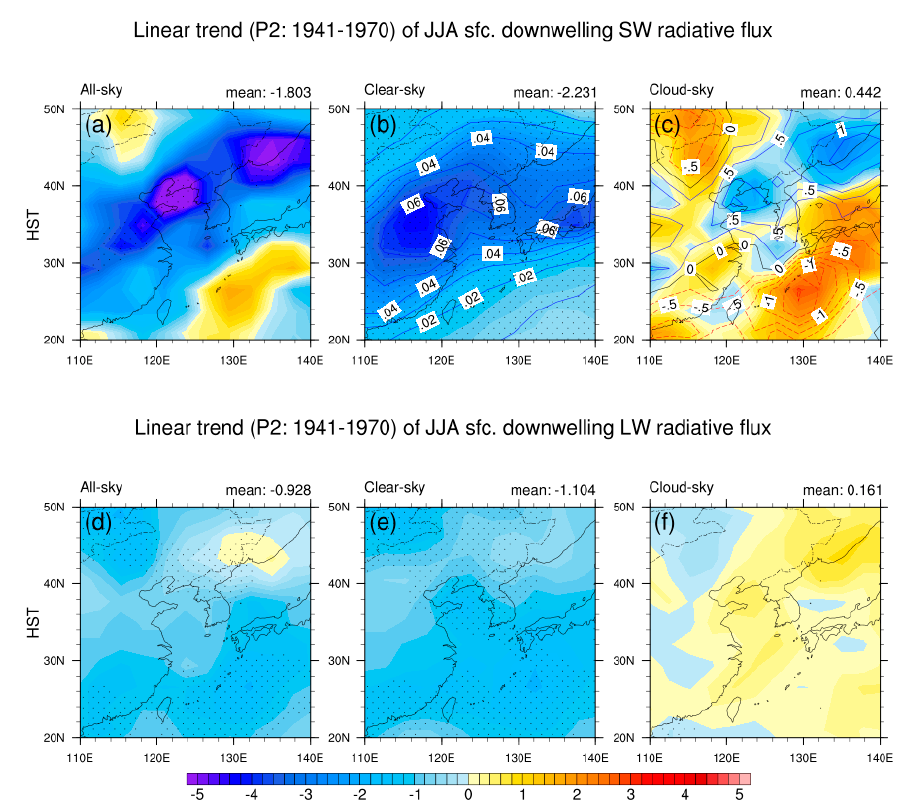
Figure 7. The linear trends of the JJA mean downwelling SW (upper panel, shading) and LW (bottom panel, shading) radiative flux at the surface (Wm − 2 decade − 1 , positive downward) according to cloud condition in the middle 20th century (1941–1970); ( a , d ) all-sky; ( b , e ) clear-sky with total aerosol optical depth trend (contour in upper panel, positive solid line); ( c , f ) cloudy-sky with total cloud fraction trend (contour in upper panel) in HST. The dotted areas indicate that the trends are statistically significant at 10% level. The domain average has been shown in the right corner. Table 5. The land-mean linear trend (Wm − 2 decade − 1 ) of the JJA-mean downwelling SW, LW, and the net radiation at the surface from the HST, AER, GHG, and NAT simulations for P2. The numbers in the parenthesis are the corresponding values for the clear-sky and cloudy-sky condition. SW all-sky (clear-sky / cloud-sky) LW all-sky (clear-sky / cloud-sky) SW + LW all-sky (clear-sky /